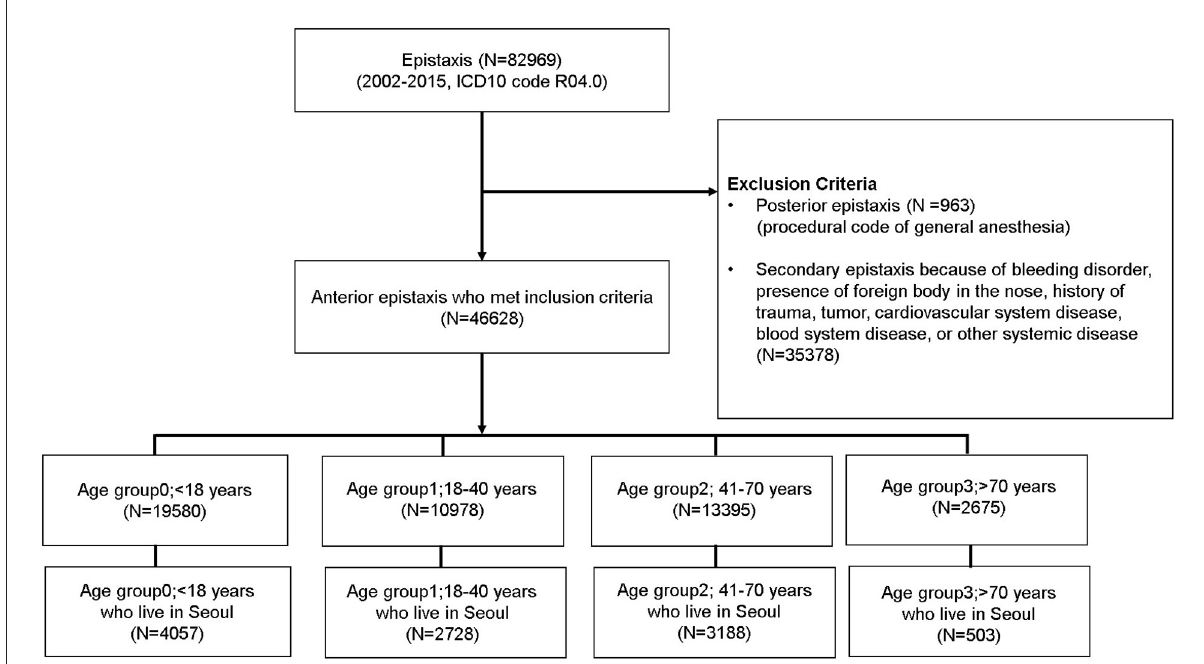
FIGURE1 Cohort selection and study design. Patients with epistaxis who visited the hospital were selected from the National Health Informational Database and were divided into four groups according to age.